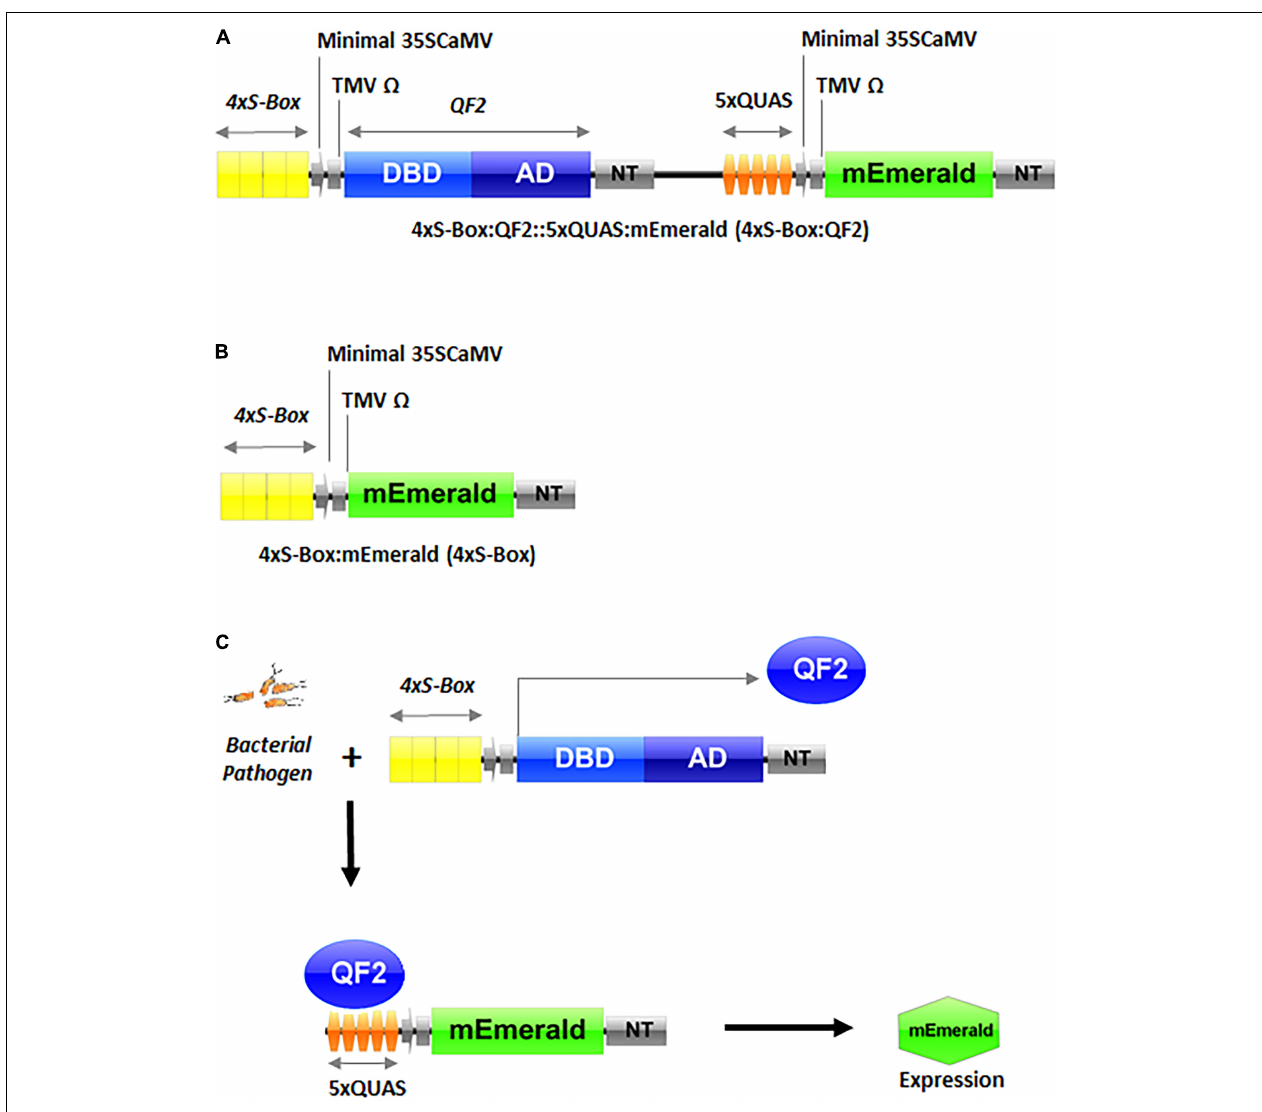
FIGURE 1 | Schematic representation of inducible pathogen phytosensor constructs and illustration of the promoter-transcription factor functionality. (A) Phytosensor construct 4xS-Box:QF2::5xQUAS:mEmerald (4xS-Box:QF2) with the Q-system. (B) Pathogen phytosensor construct 4xS-Box:mEmerald (4xS-Box) without the Q-system. (C) Phytosensing mechanism illustrating the functional components of the Q-system. As shown earlier, the 4xS-Box synthetic promoter detects bacterial pathogen infection, resulting in the expression of QF2 protein. The subsequent binding of QF2 to the 5xQUAS promoter results in expression of the mEmerald reporter. DBD, DNA binding domain; AD, activation domain; QF2, Q-system transcription factor variant; QUAS, Q-system effector repeat promoter sequence; NT, nopaline synthase terminator; minimal 35SCaMV, minimal ( − 46) 35S promoter of the Cauliflower mosaic virus (CaMV); TMV (cid:127) , 5 (cid:48) -leader